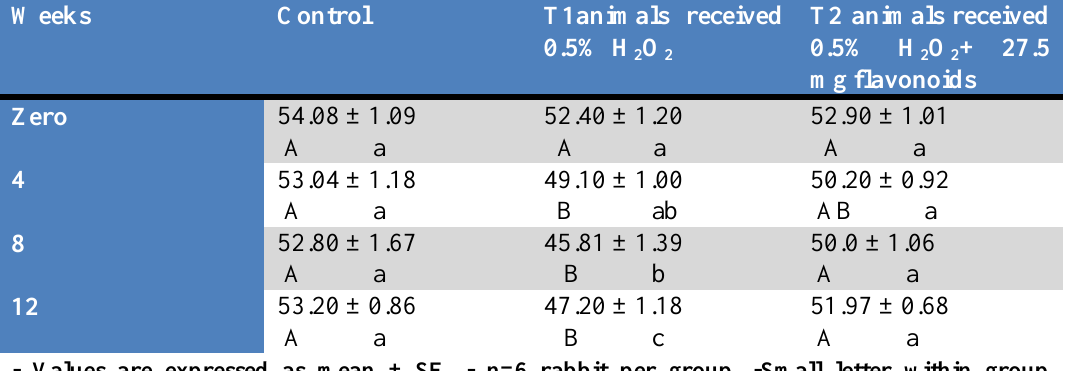
Table (7): Effect of flavonoids extracted from black seeds (Nigella sativa L.) for twelve weeks on serum high density lipoprptein (HDL-C) concentration (mg/dl) in control and H O plus flavonoids treated adult male rabbit . 2 2